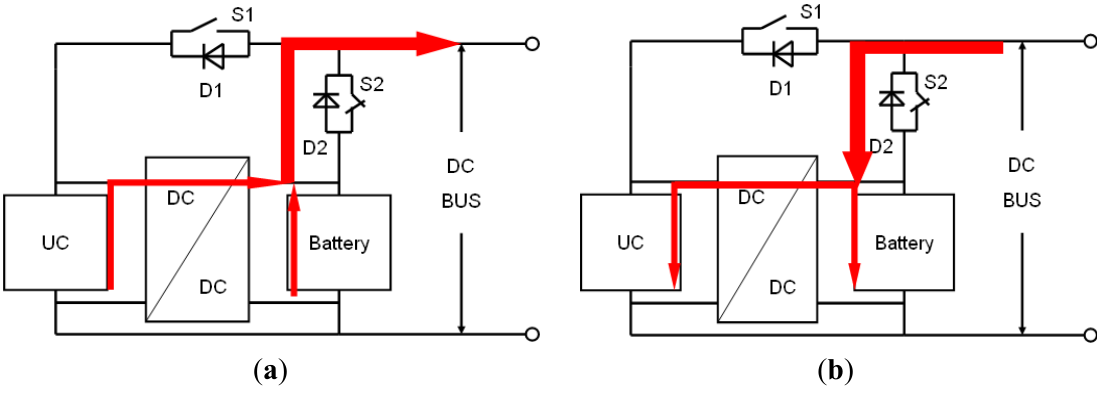
Figure 4. Energy flows in Mode II for the medium power level: ( a ) HESS supplies